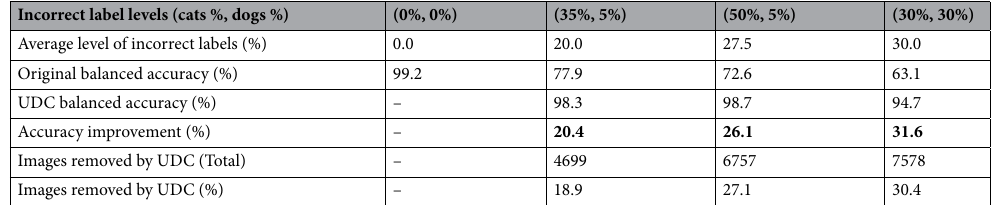
Table 1. Results from a single round of UDC applied to various incorrect label levels. The bold font is to draw attention of the reader that there is an accuracy improvement. Cats % is the percentage of cat images incorrectly labeled as dogs, vice versa. Baseline model is assumed to contain 0% error in both classes, denoted (0%,